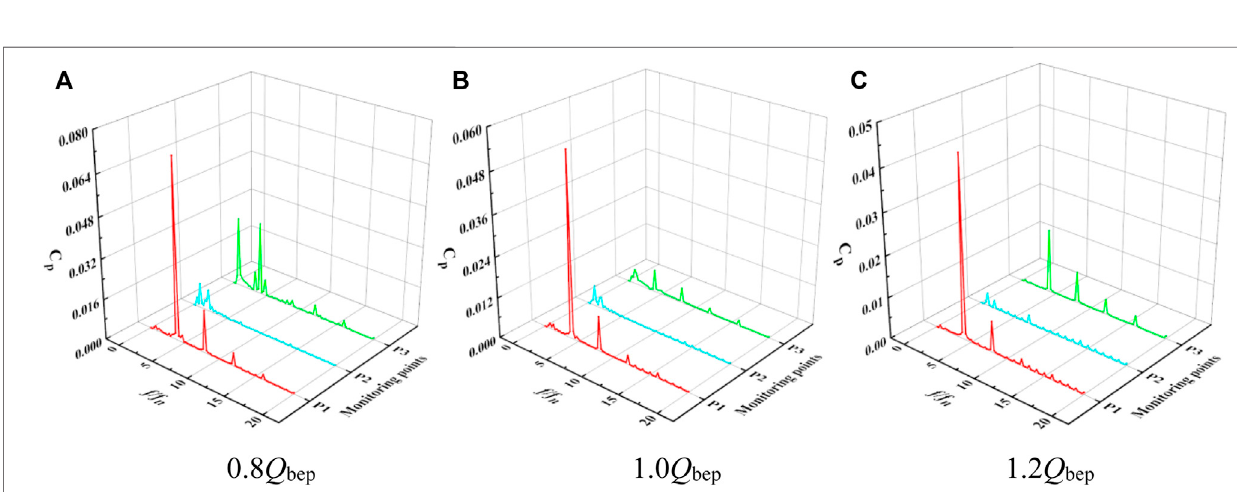
FIGURE 13 | Frequency domain diagram of pressure pulsation at each monitoring point of the